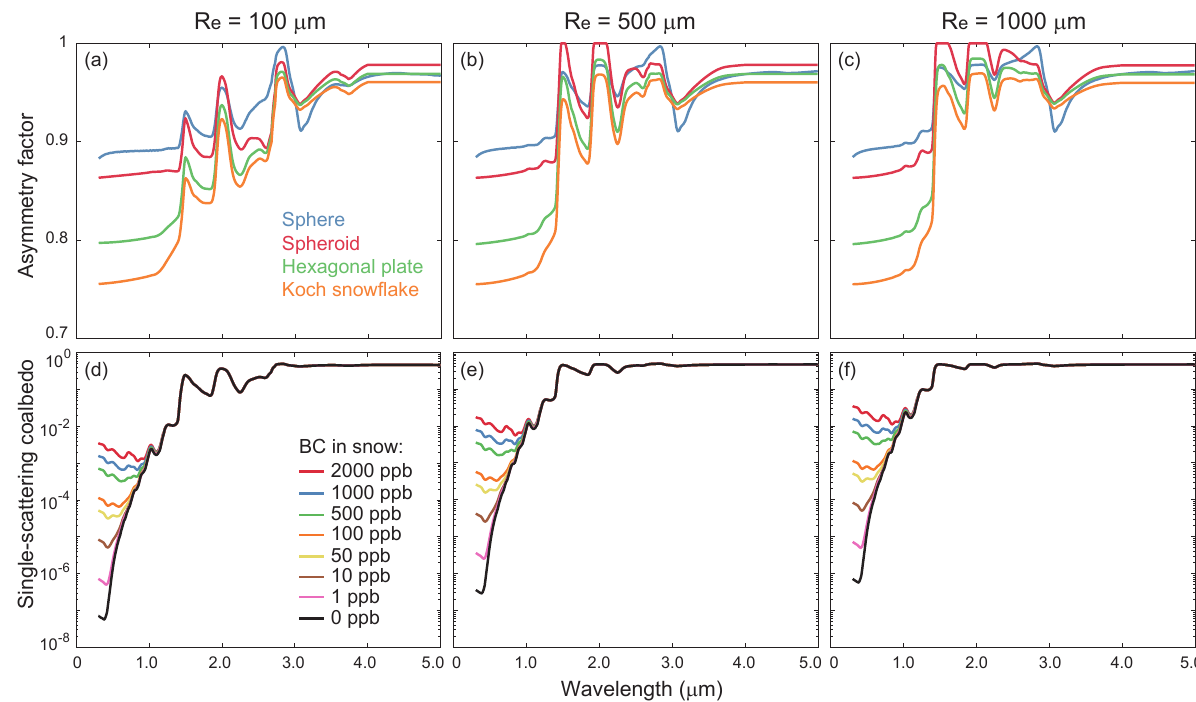
Figure 2. (a–c) Spectral (0.3–5µm) asymmetry factors of pure snow with effective radii ( R e ) of (a) 100, (b) 500, and (c) 1000µm for sphere (blue), spheroid (red), hexagonal plate (green), and Koch snowflake (orange) derived from the updated SNICAR model. (d–f) Spectral single- scattering co-albedo of snow grains internally mixed with different BC concentrations (indicated by different colors) for snow effective radii ( R e ) of (d) 100, (e) 500, and (f) 1000µm derived from the updated SNICAR model. Note that the y axes in (d–f) are in logarithmic scales.